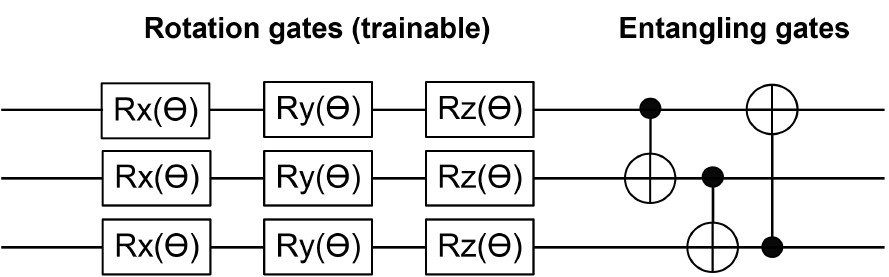
Figure 2. Circuit representation for three qubits of one layer of the PQC used in this work. Single qubit rotation gates with trainable rotation angles are followed by an entangling layer made of C-NOT gates acting on neighboring